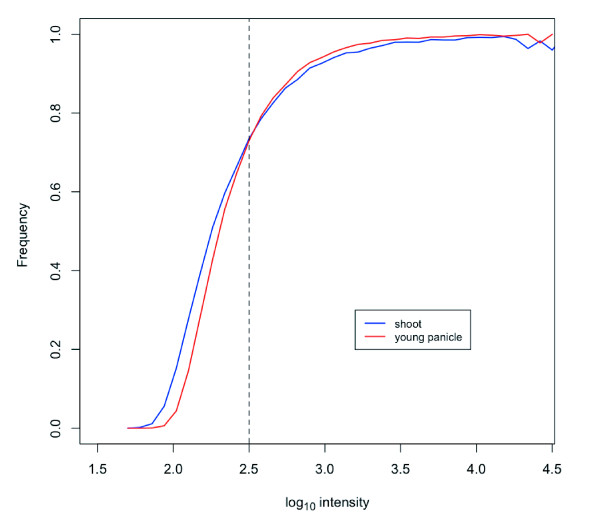
Effect of signal intensity on the intensity difference between PM and MM probes for completely match transcripts. Four replicates of shoot or young panicle data were analyzed by ANOVA, and the frequency of probe pairs with significantly different intensities (p < 0.05) between PM and MM were plotted against averaged PM signal intensities within 0.1. The dashed line indicates the cut-off signal value (2.5) for mRNA analysis.